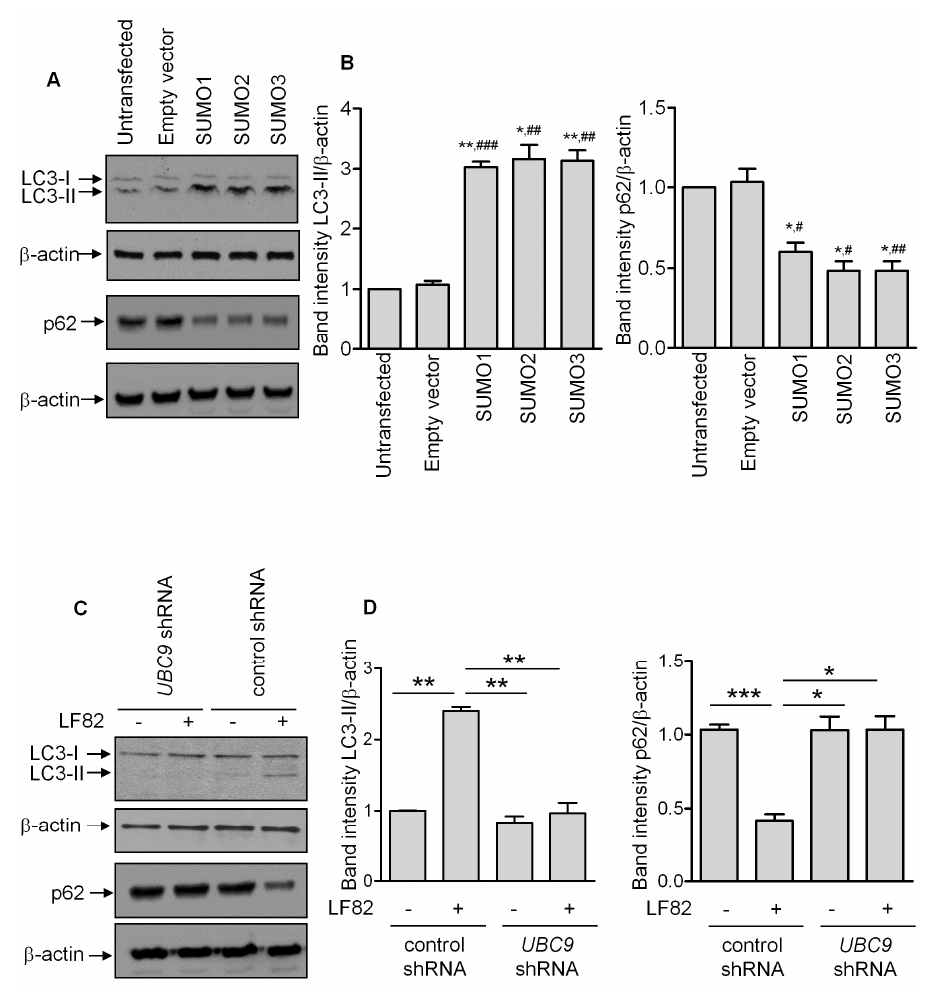
Figure 3. SUMOylation regulates autophagy response. ( A ) Western blot analysis for the shift of LC3-I toward LC3-II and p62 levels in T84 cells transfected with SUMO-encoding plasmids or an empty vector. ( B ) Quantification of LC3-II/ β -actin or p62/ β -actin band intensity from three independent blots. (* p < 0.05; ** p ≤ 0.005) vs. untrasfected; ( # p < 0.05; ## p ≤ 0.005; ### p ≤ 0.001) vs. empty vector. ( C ) T84 cells stably transfected with UBC9 shRNA or an empty shRNA were infected with the LF82 strain. The shift of LC3-I toward LC3-II and p62 levels were analyzed by Western blot. ( D ) Quantification of LC3-II/ β -actin or p62/ β -actin band intensity from three independent blots. * p < 0.05; ** p ≤ 0.005; *** p ≤ 0.001.